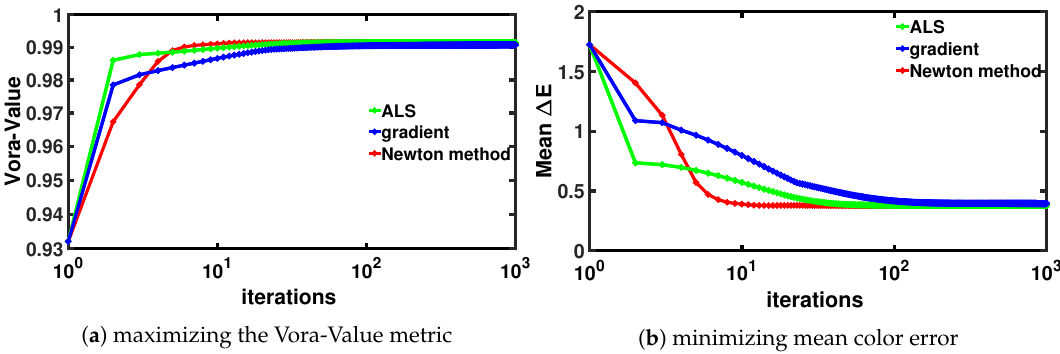
Figure 4. Algorithm convergence in terms of ( a ) Vora-Value and ( b ) mean ∆ E ∗